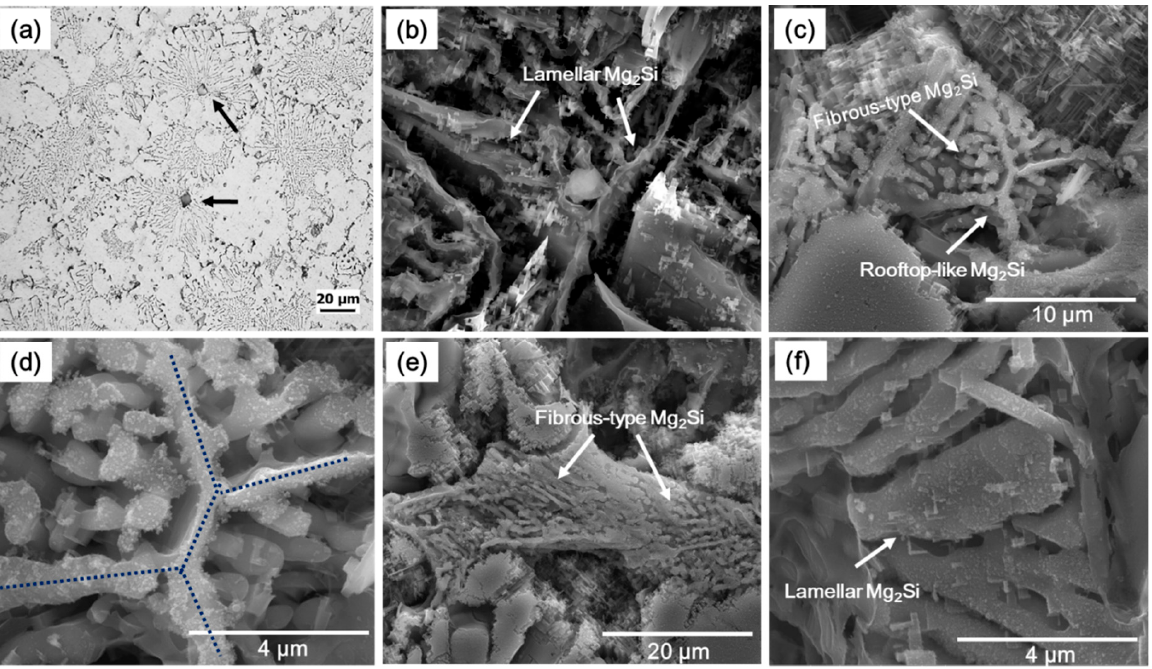
Figure 4. ( a ) optical micrograph of E1 alloy which Black arrows are pointing at the primary Mg2Si phases located in the middle of binary eutectic Al–Mg2Si phases. The rest are SEM microstructures, acquired using the SE mode, of deep-etched investigated alloys; ( b ) the coarse curved lamellar binary eutectic structure found in A1 alloy. ( c ) Low and ( d ) high magnification showing the rooftop-like Mg2Si phase in E1 alloy. ( e , f ) Fibrous-type modified and refined lamellar binary eutectic Al–Mg2Si phases in E1 alloy, respectively.